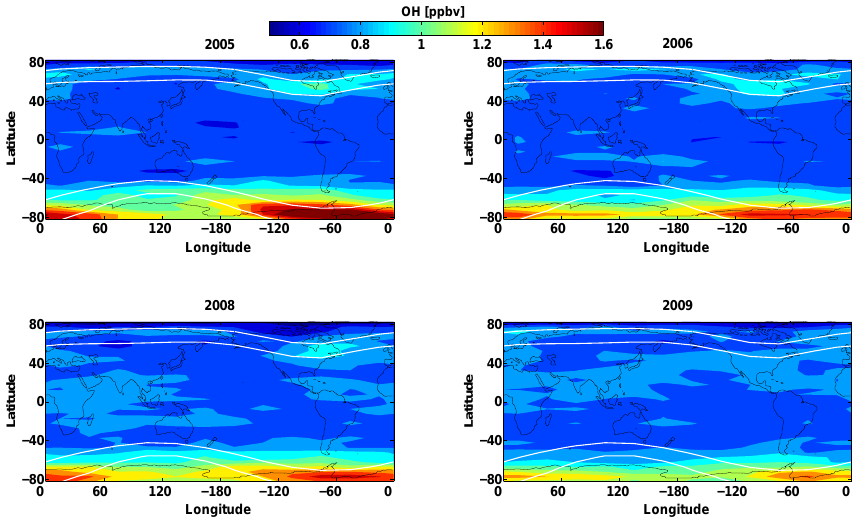
Fig. 2. World maps showing medians of nighttime OH in 2005, 2006, 2008 and 2009 averaged between 70 and 78km. Median values were calculated for each 5 ◦ (latitude) × 30 ◦ (longitude) bins between latitudes 82 ◦ N to 82 ◦ S and longitudes 180 ◦ W to 180 ◦ E. Approximate geomagnetic latitudes 55–72 ◦ N/S are indicated by superimposed white